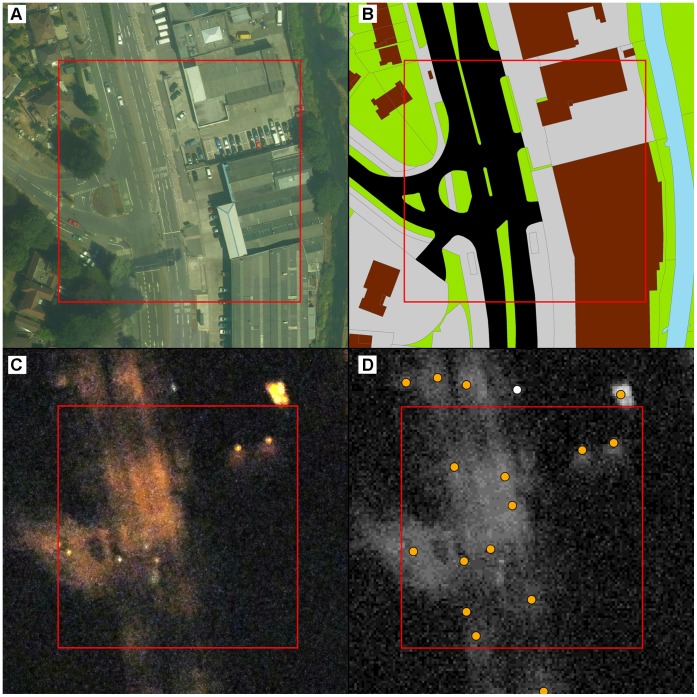
Aerial photography, mapping and lighting indicators for a 100 m square manufacturing zone and road intersection.(A) A daytime aerial photograph, reprinted from original photography under a CC BY license, with permission from Bluesky International Limited, original copyright [2007] (B) OS MasterMap land-cover and land-use parcels reprinted from original mapping under a CC BY license, with permission from the Ordinance Survey, original copyright [2008], (C) a night time aerial colour photograph reprinted from original aerial photography under a CC BY license, with permission from the Environment Agency, original copyright [2009] and (D) a raster representing ground lux, overlain by a point layer representing lamp centres.